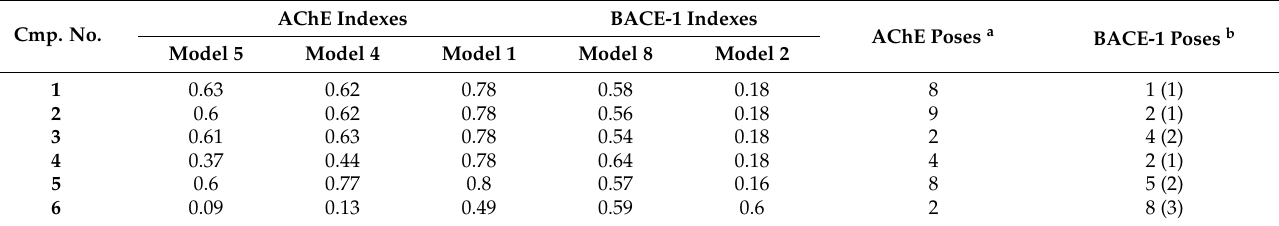
Table 6. Models indexes and docking results for the six hit